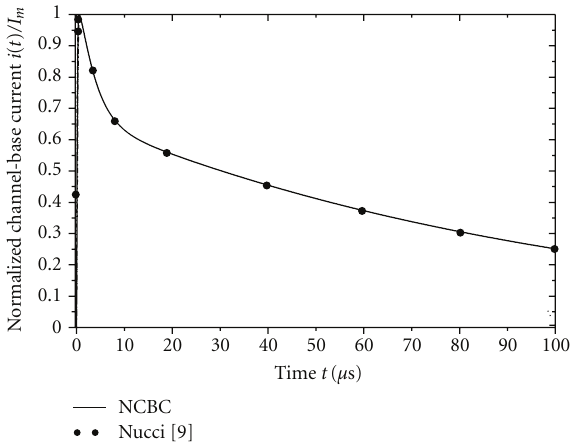
Figure 2: One-peaked NCBC function denoted with the full line approximating channel-base current from [9] denoted with dots.